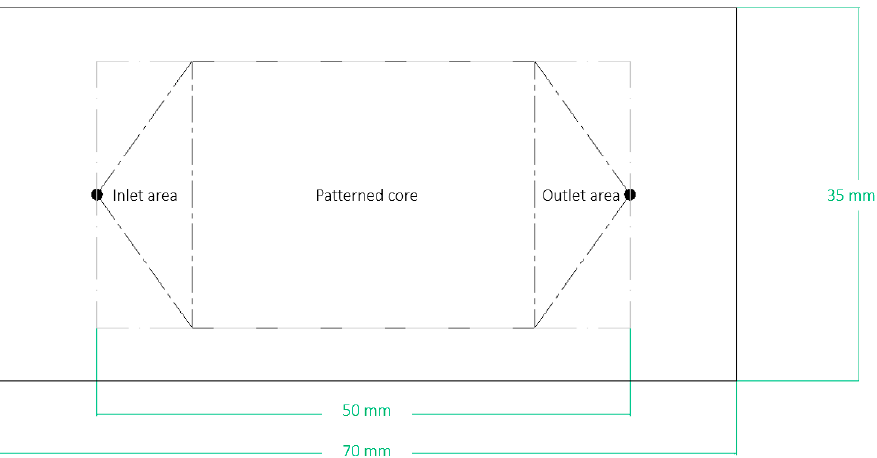
Figure 3. Layout of the microfluidic device, showing the inlet and outlet are and the pattern. The linear dimensions refer to the total extension of the devices and the inlet–outlet port distance.